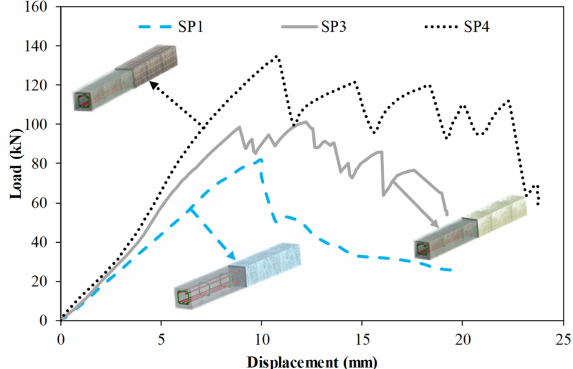
Figure 8. Comparison of specimens SP1, SP3 and